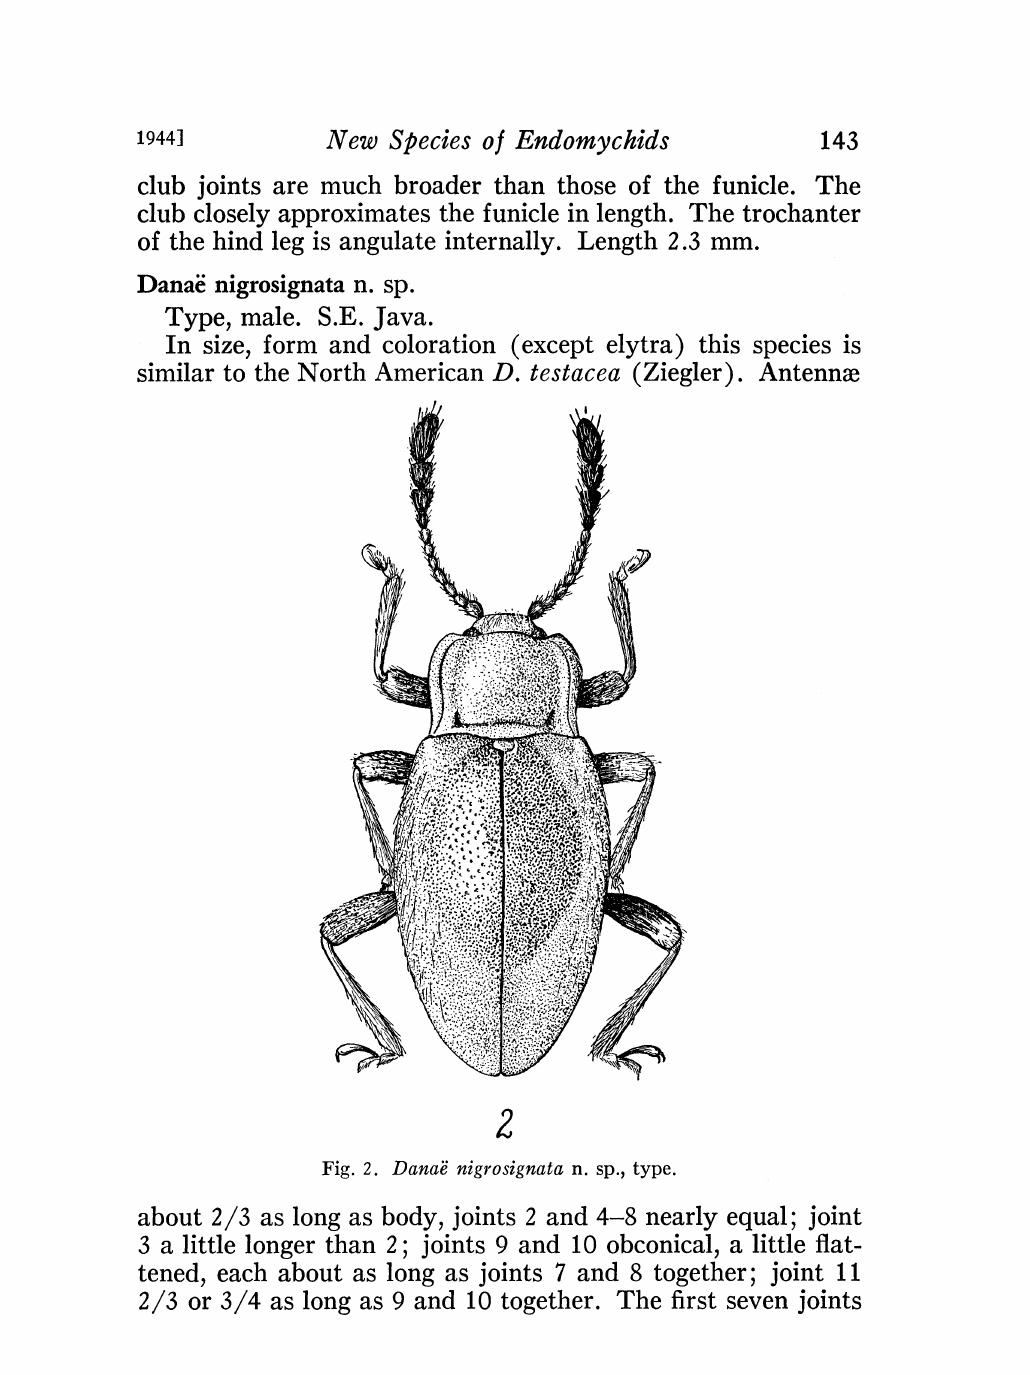
Fig. 2. Dana nigrosignata n. sp.,